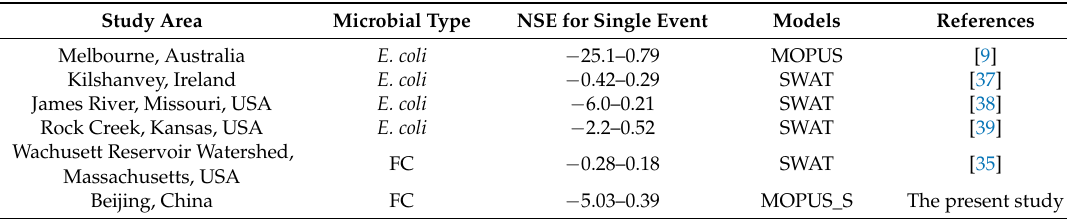
Table 4. Modelling efficiency of